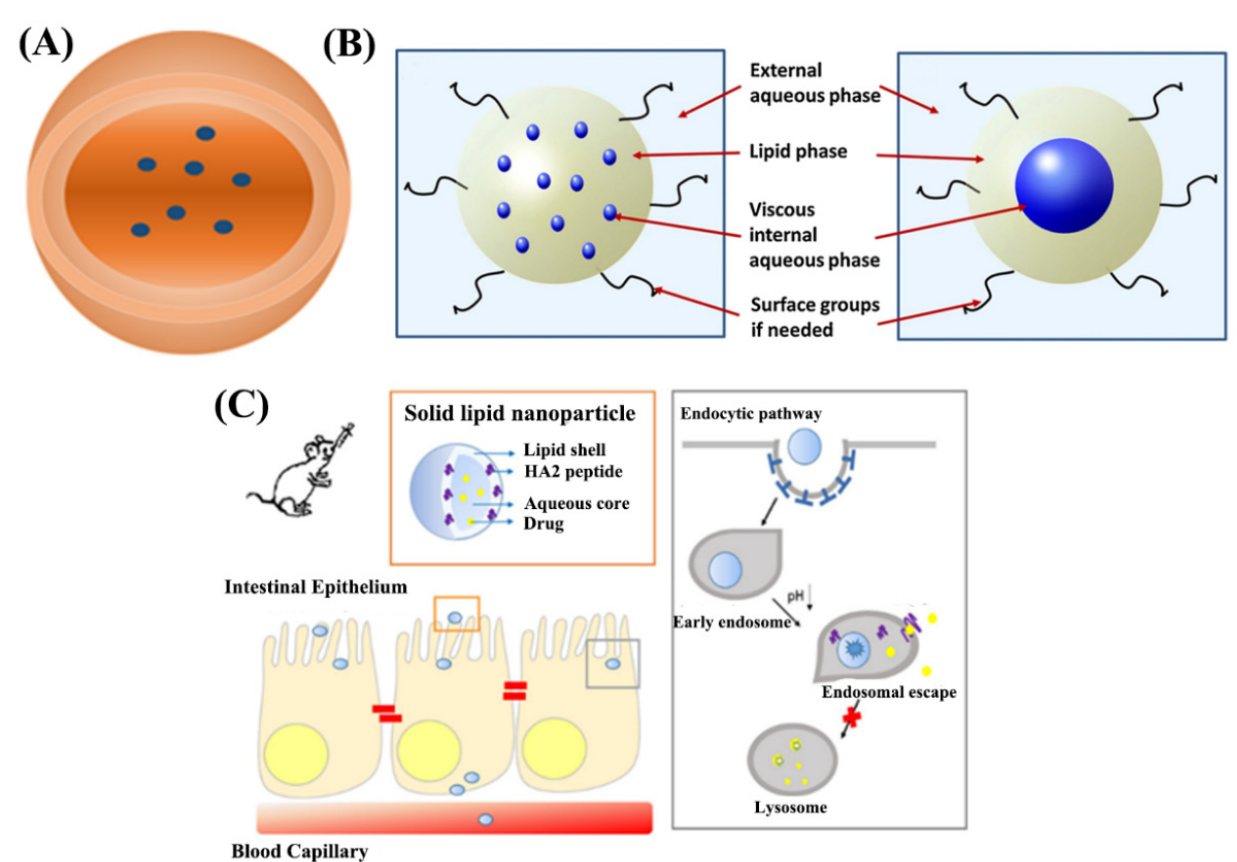
Figure 5. ( A ) Structure of SLNs. ( B ) Schematic representation of possible structures of VEN. ( C ) Schematic diagram of SLN and its behavior in intestinal epithelium.